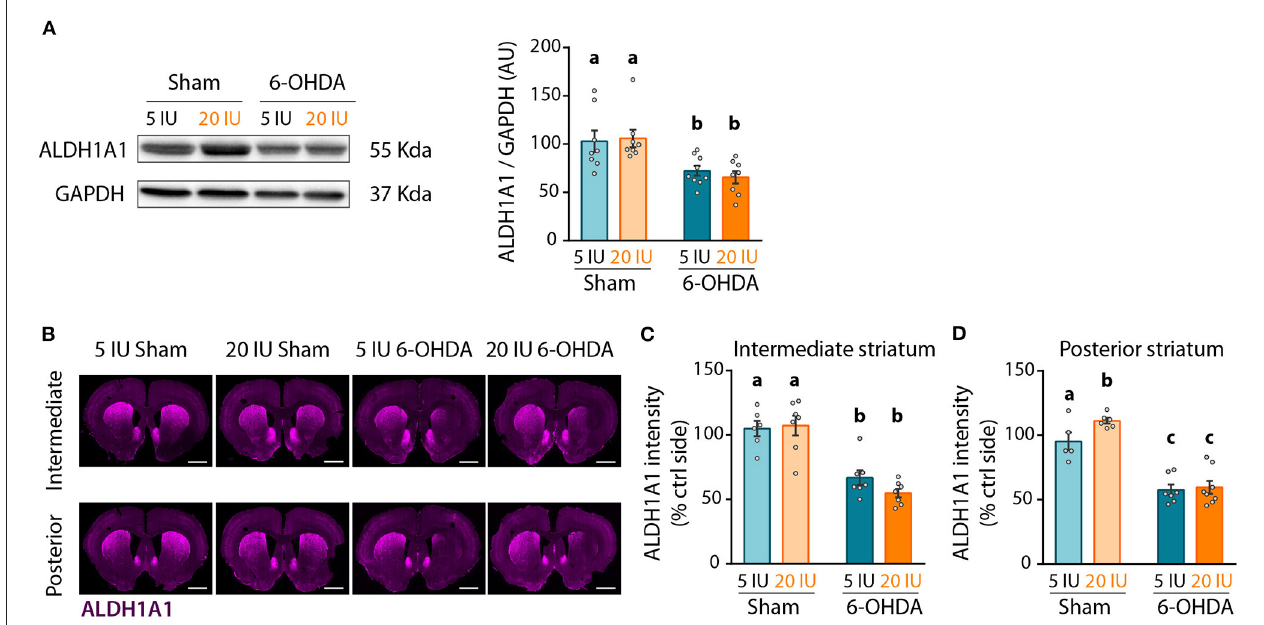
FIGURE 8 | Impact of 6-OHDA lesion and dietary vitamin A on extent of ALDH1A1 + fibers in the striatum. (A) Representative western blot for aldehyde dehydrogenase A subtype a1 (ALDH1A1) in striatum homogenates (left inset) and quantification (graph). Protein expression levels were normalized with GAPDH for each sample. (B) Representative images for the 4 experimental groups of intermediate and posterior striatum (lesioned and control sides) immunostained for ALDH1A1 (magenta). Scale bar: 1000 µ m. (C,D) Quantification of fluorescence intensity of ALDH1A1 staining in intermediate (C) and posterior (D) striatum. ALDH1A1 intensity is normalized to the ipsilateral side. Results are expressed as means ± SEM with individual data points. a–c: values significantly different ( p < 0.005). Details of the statistical analysis are summarized in Table 3